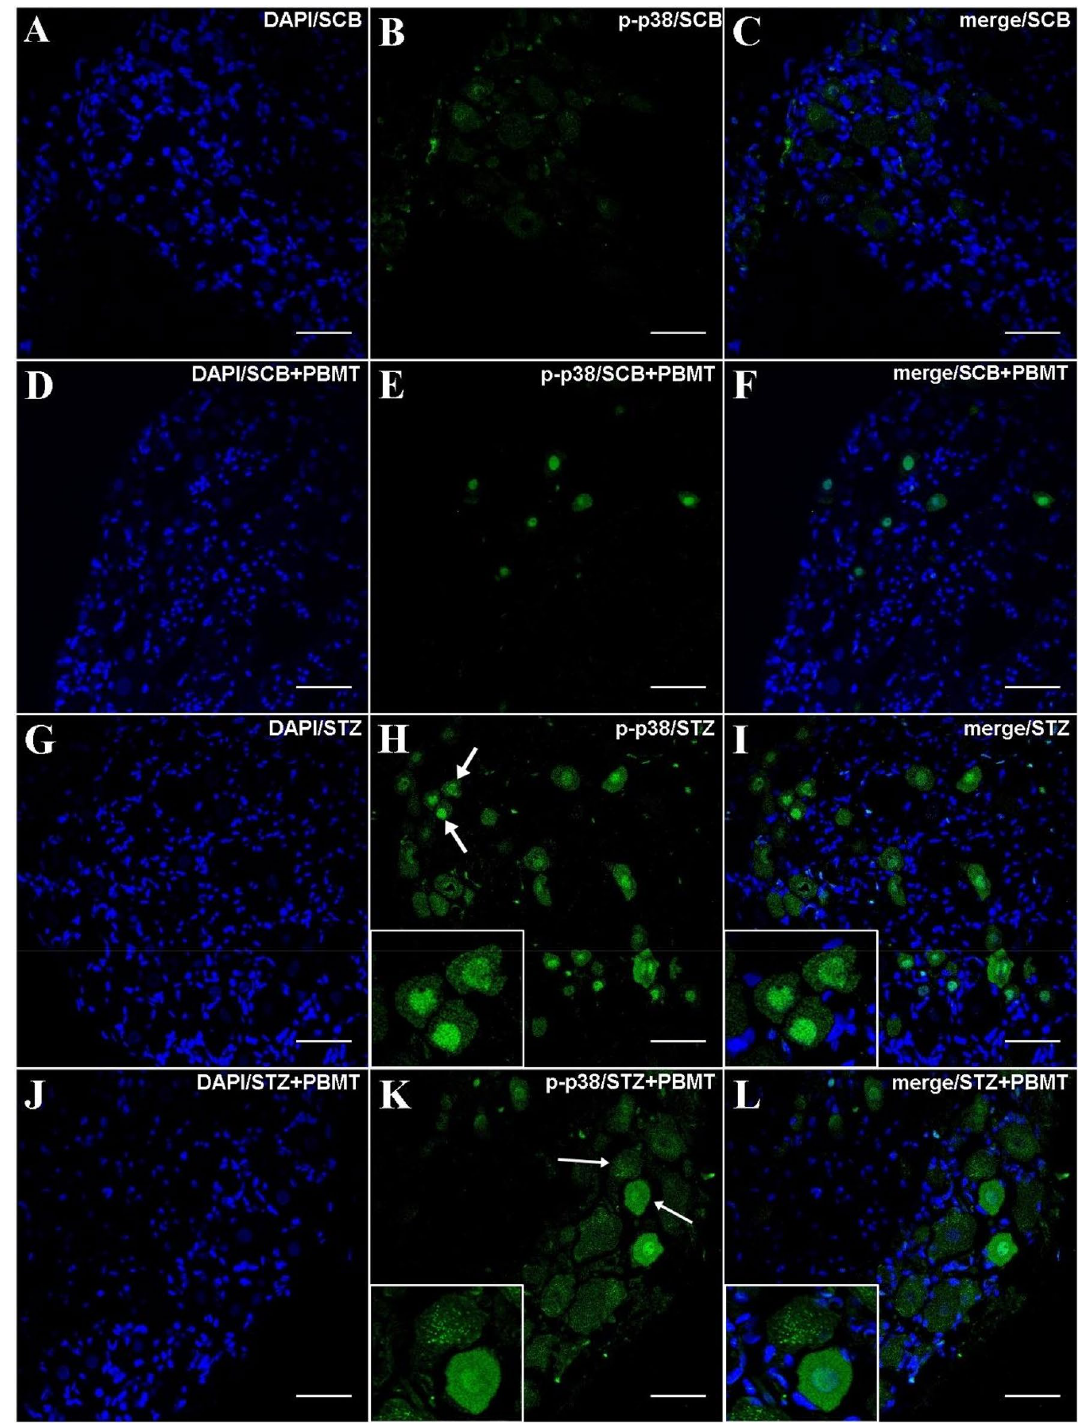
Figure 5. DRG histological micrographs of p-p38 MAPK by confocal microscopy. DRG transversal 14 µm-thick sections were submitted to IF protocol for staining endogenous p38 phosphorylation in Thr180 and Tyr182 ( B , E , H , K ). DAPI for nuclear staining is shown in ( A , D , G , J ). Merge (DAPI + p-p38) images are also shown in ( C , F , I , L ). In ( H ) and ( K ), white arrows point to the zoomed-in areas. Details are shown in the left corner of ( H , I , K , L ). Magnification: ×40; scale bars: 50